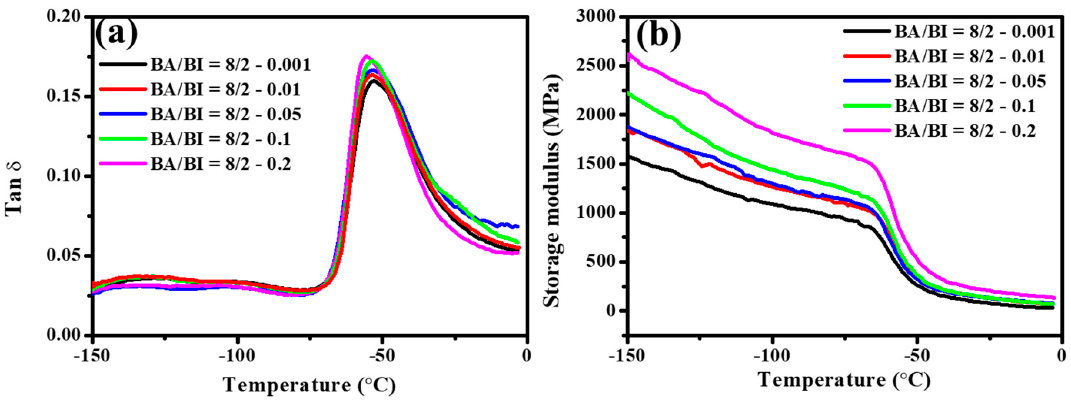
Figure 13. ( a ) Tan δ and ( b ) storage modulus of the PBABI copolyesters at di ff erent concentrations of EDTA.